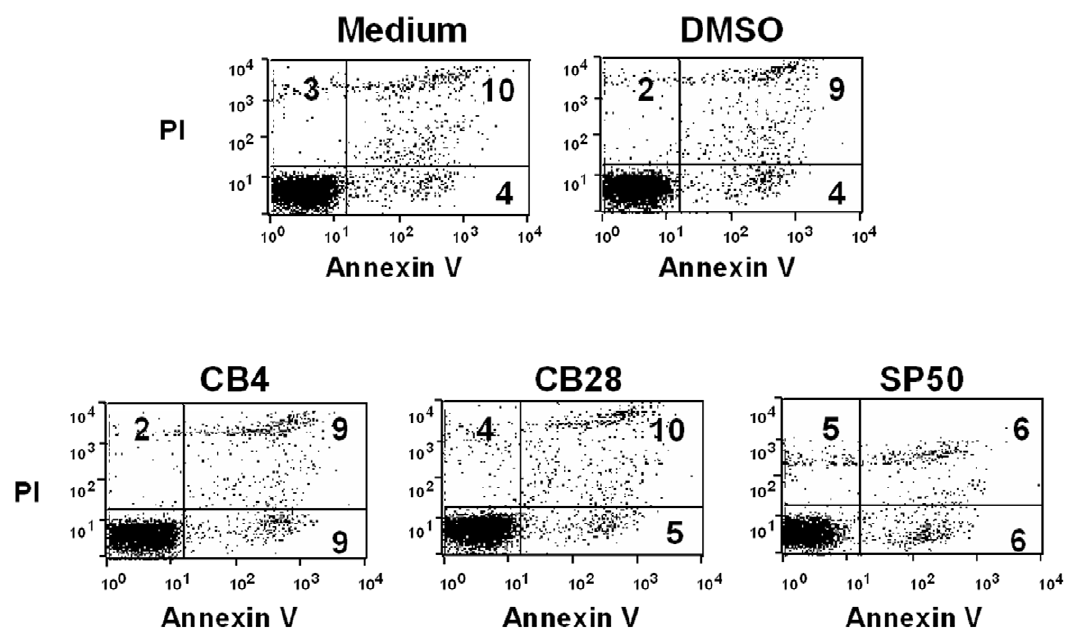
Figure 6. Assessment of CCRF-CEM cell viability by propidium iodide (PI) and annexin V labeling following treatment with CCR4 antagonists. Propidium iodide (PI) labels cells lacking intact plasma membranes and hence at an advanced stage of cell death. Annexin V labels cells at early and late stages of apoptosis. Plots show representative data for cells cultured in medium alone or in medium to which solvent (DMSO) or antagonist has been added. Numbers indicate percentage of cells in each quadrant.